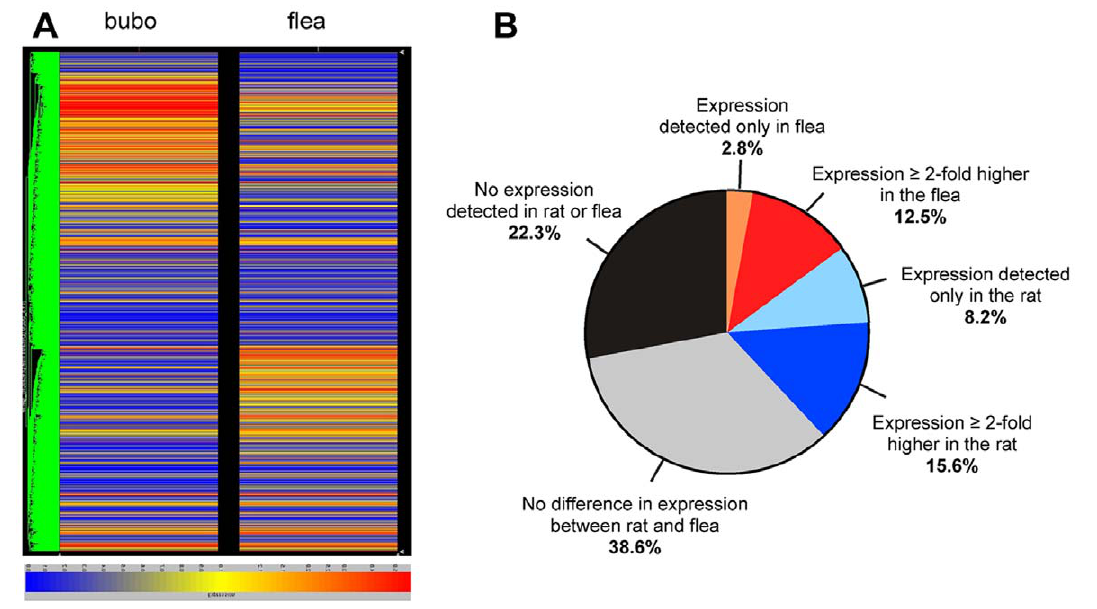
Figure 3. Distinct Y.pestis gene expression profiles in flea and rat hosts. (A) Hierarchichal clustering of normalized microarray data sets of Y. pestis gene expression in the rat bubo and the flea. The scale indicates relative transcript levels (blue=low; red=high) for all 4,638 Y. pestis genes on the microarray. (B) Percentages of Y. pestis genes that are differentially regulated (or not) in the flea and in the rat bubo.